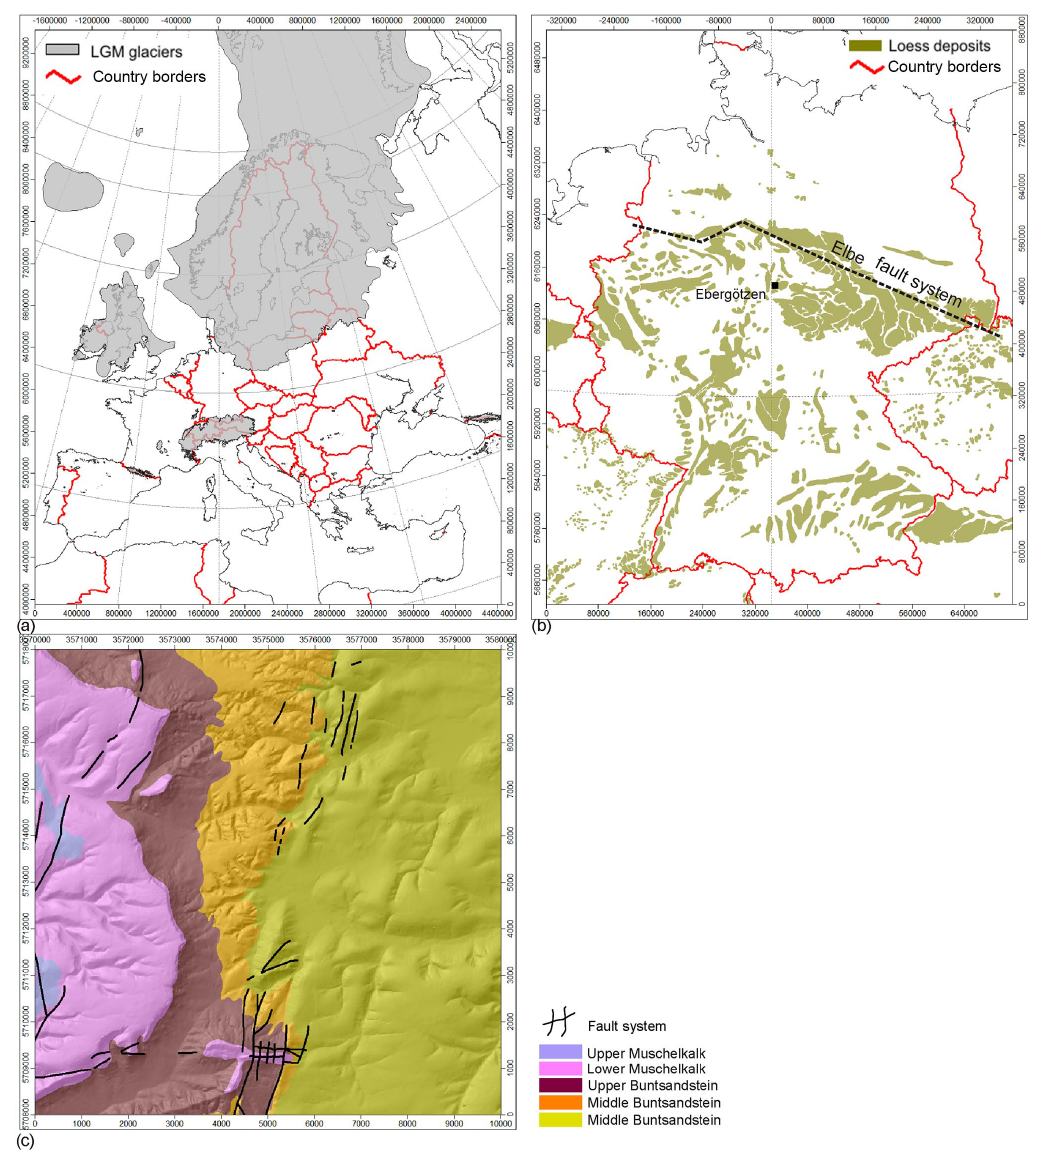
Figure 1. Location of the study site: (a) glacial ice sheets of the Last Glacial Maximum (20–18kaBP) in Europe, data from Ehlers and Gibbard (2004); (b) loess deposits in Germany, data from Haase et al. (2007), test site at Ebergötzen as black rectangle; (c) simplified geological map of test site at Ebergötzen, according to Ehlbracht (2000). For our purpose, the areas with quaternary deposits were